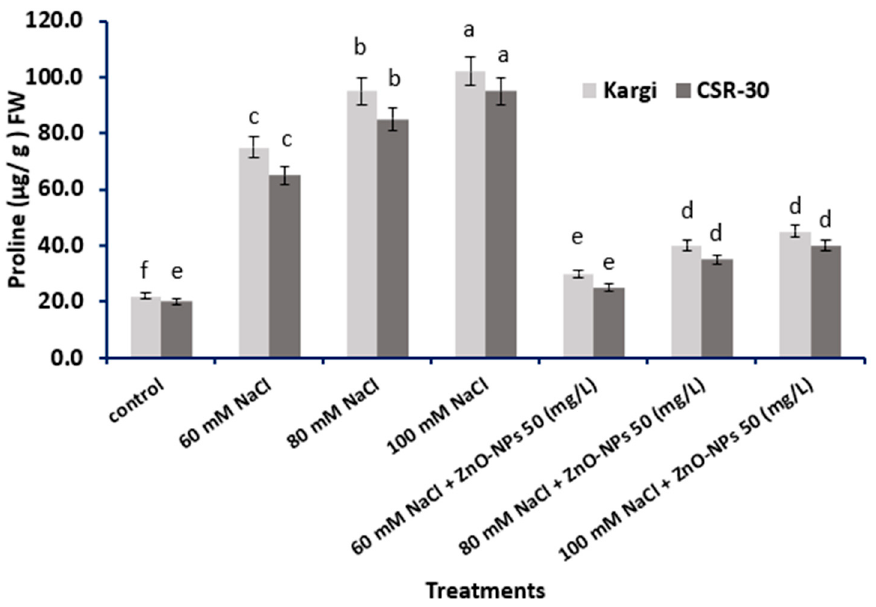
Figure 2. Impact of ZnO-NPs on proline accumulation in Kargi and CSR 30 leaves in control and under saline conditions. Values are means of three replicates; a statistically significant difference between treatments compared with control is indicated by different small alphabets (a–f). Error bars indicate the least considerable value (LSD) at p ≤ 0.01 among the treatments.